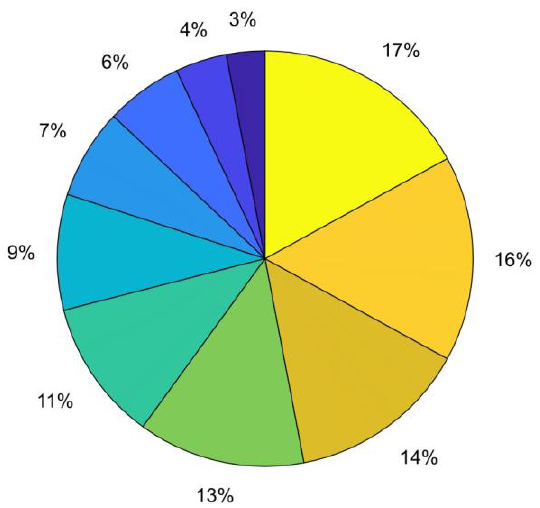
Figure 3. Fitness roulette wheel reflecting the proportion of individual fitness.